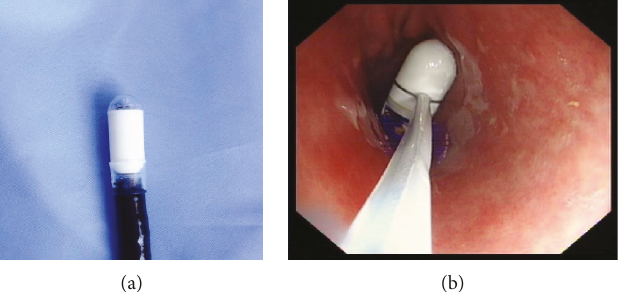
Figure 1: (a) Transparent hood-assisted endoscopic delivery (capsule endoscope loaded on the tip of gastroscope by a transparent hood); (b) endoscopic snare